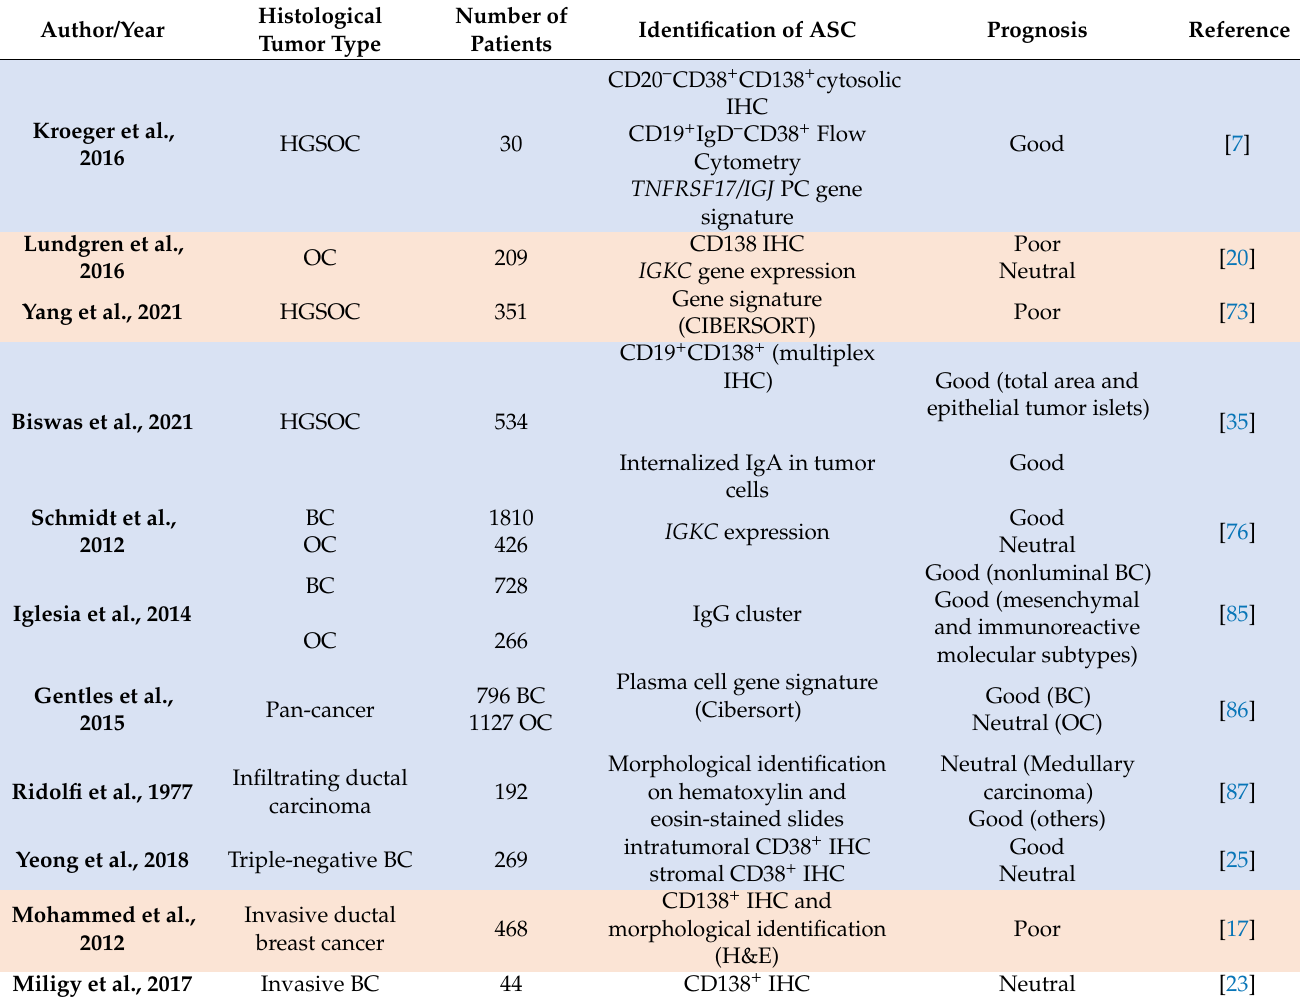
Table 1. ASC impact on patient prognosis. Studies reporting a positive impact are highlighted in blue, while those documenting a negative impact are highlighted in